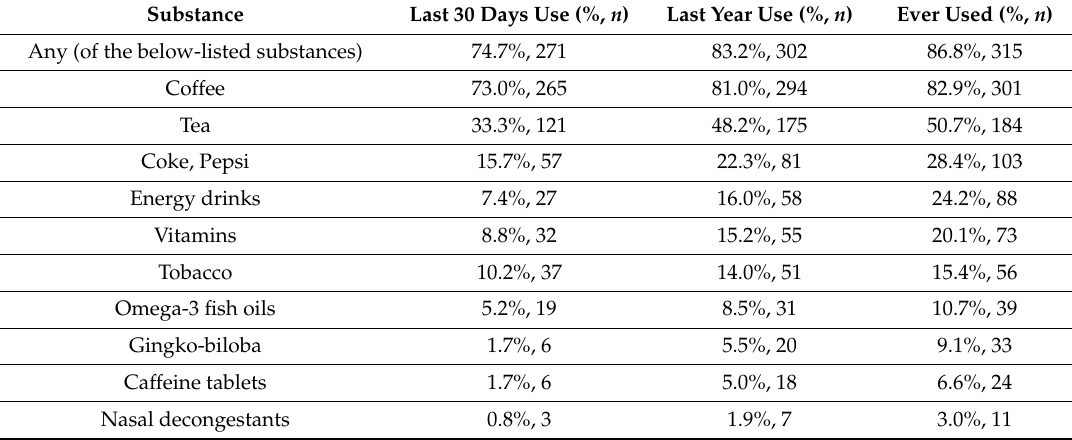
Table 1. Lifetime, last year, last 30 days use of substances as cognitive enhancers by Italian medical students at the University of Modena and Reggio Emilia,